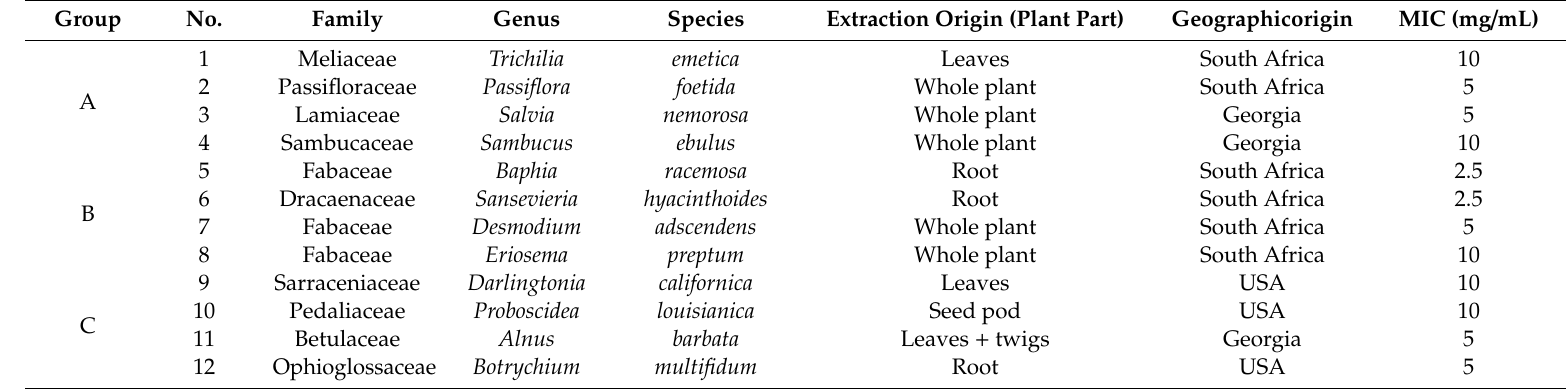
Table 1. The 12 plant extracts with antibacterial e ff ect against Listeria monocytogenes F2365. MIC—minimum inhibitory concentration; USA—United States of America.